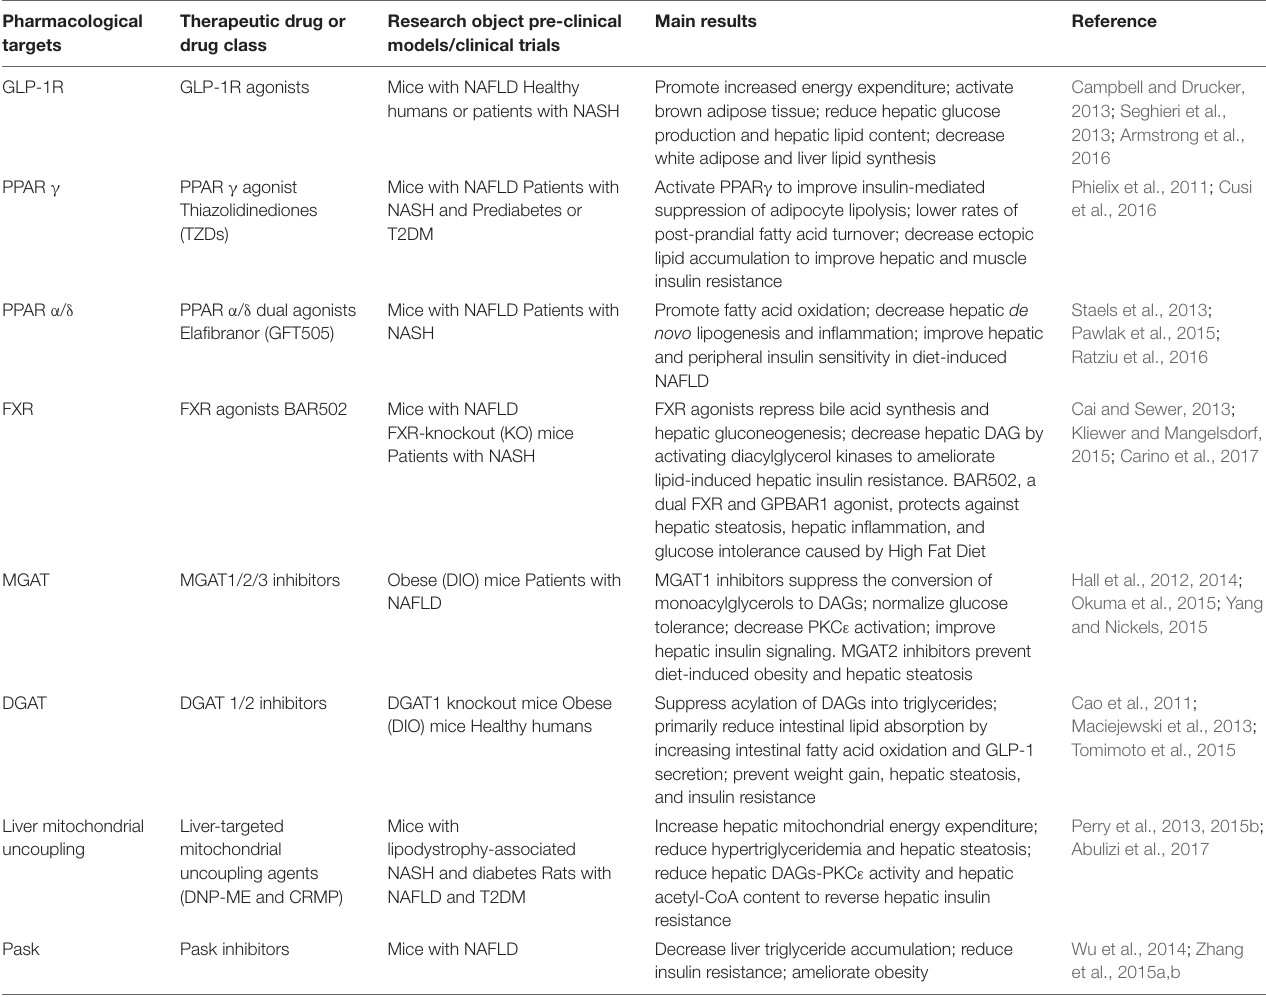
TABLE 1 | Potential and emerging targets for the treatment of non-alcoholic fatty liver disease (NAFLD) and hepatic insulin resistance. Pharmacological